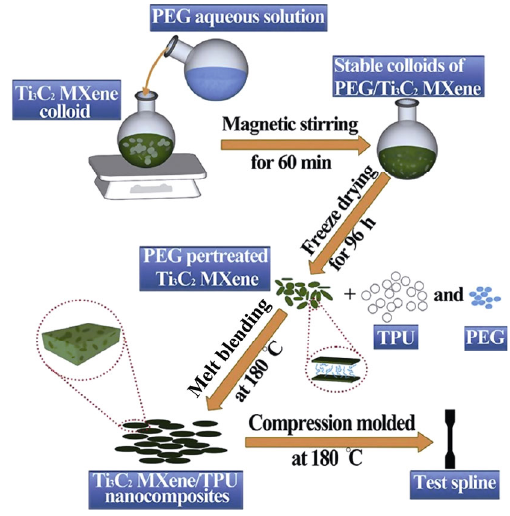
Fig. 20 Schematic of fabrication of MXene/TPU with melt blending. Reproduced with permission from